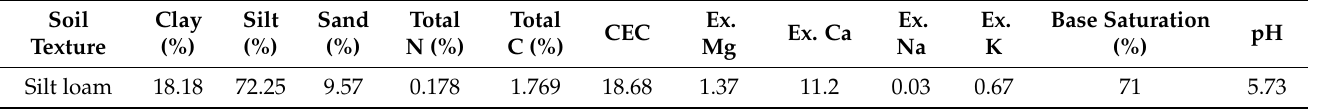
Table 1. Physical and chemical properties of silt loam soil.